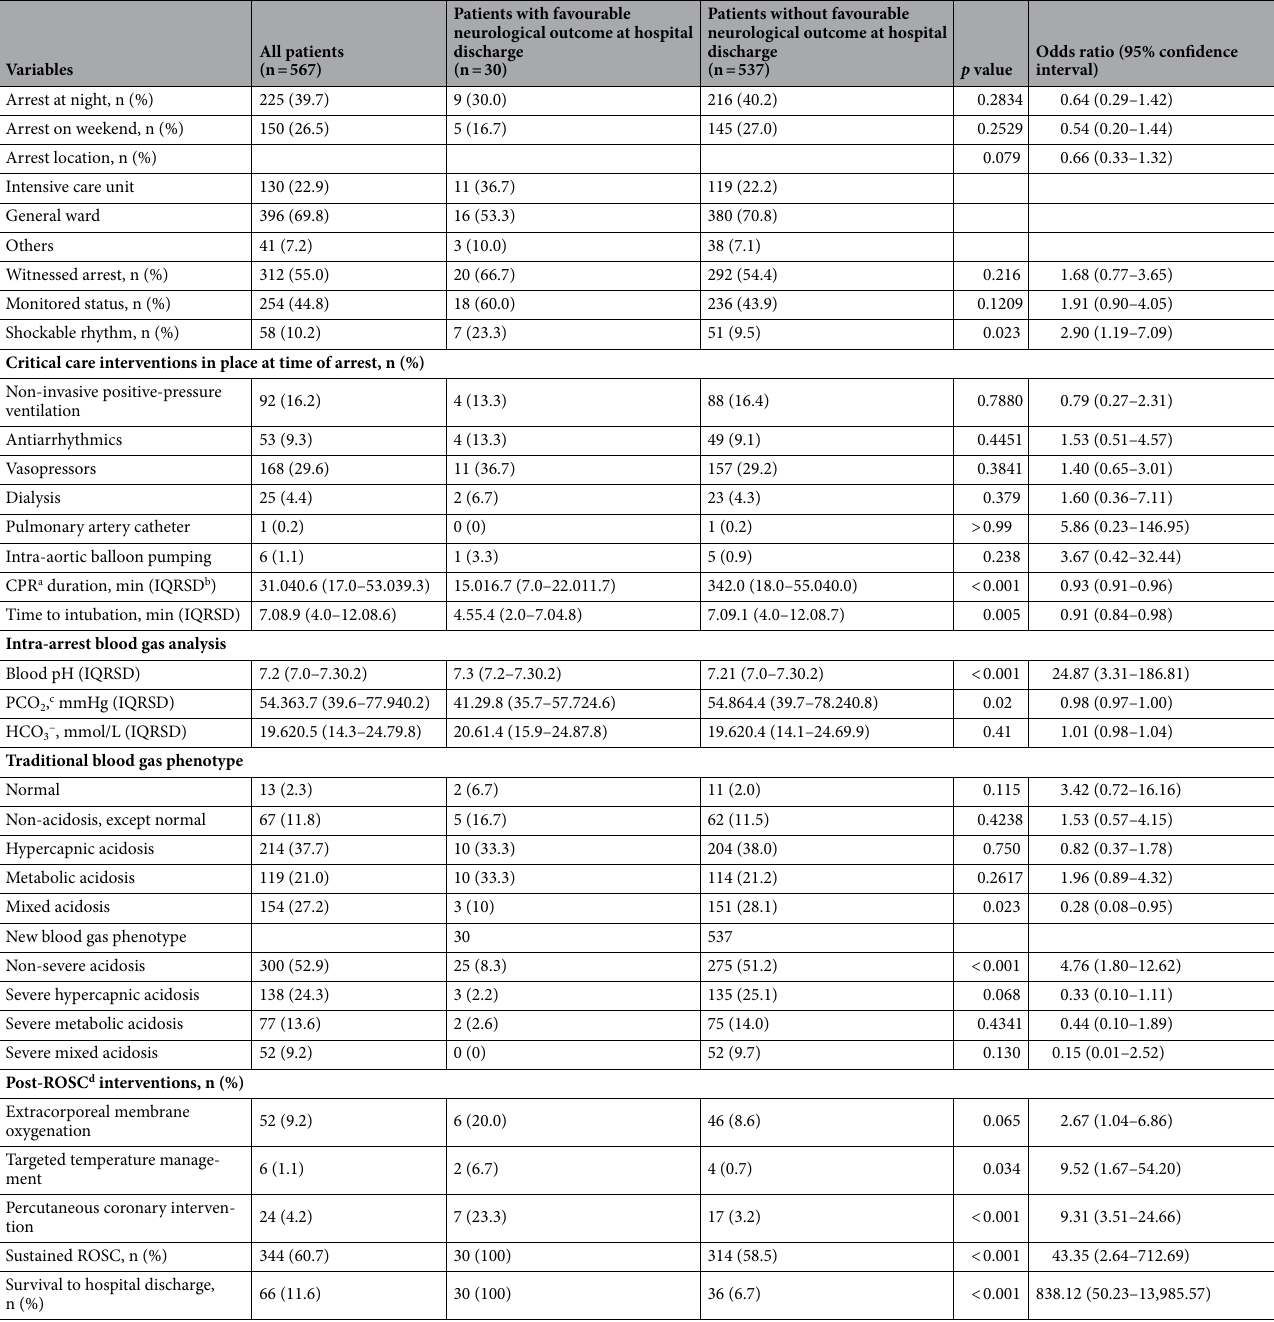
Table 2. Features, interventions and outcomes of cardiac arrest events. a CPR, cardiopulmonary resuscitation. b SDIQR, interquartile rangesstandard deviation. c PCO spontaneous